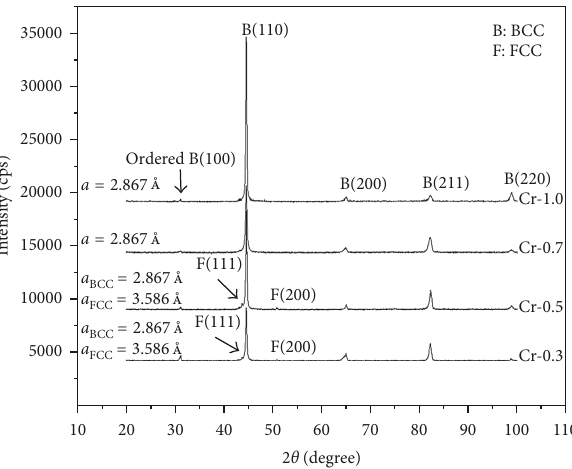
Figure 1: XRD patterns of the alloys Cr-0.3 to